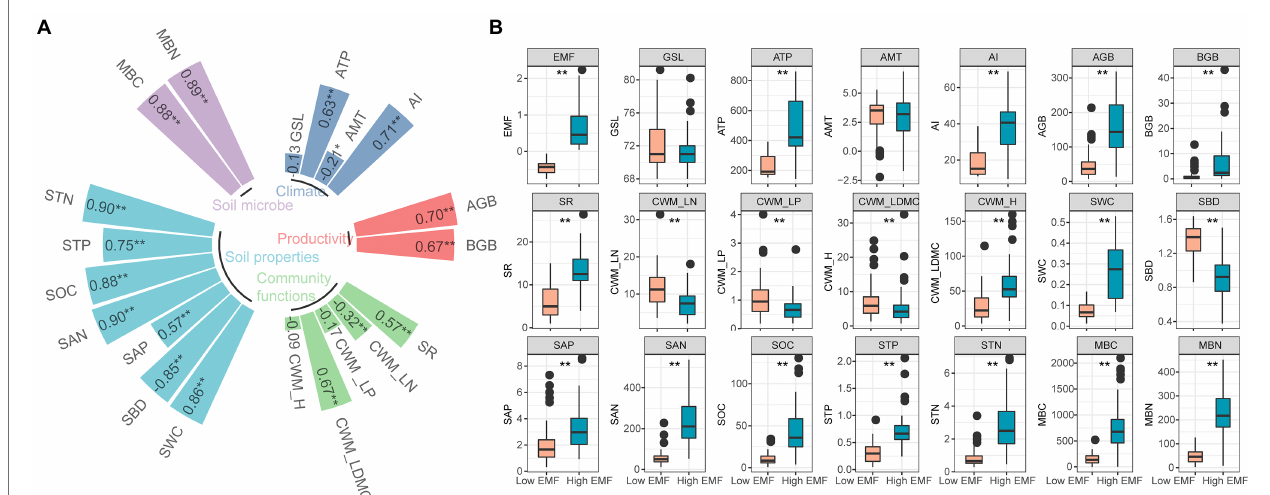
FIGURE 2 | Characteristics of ecosystem multifunctionality and environmental factors. (A) Relationship among ecosystem multifunctionality and climate, productivity, community functions, soil properties, soil microbial factors, and the value in the square represents the value of the correlation coefficient between each factor with ecosystem multifunctionality. * and ** show the significant correlations at 0.05 and 0.01 levels. (B) Difference of low and high ecosystem multifunctionality combined with environmental factors. Statistical significance between low and high ecosystem multifunctionality conditions was assessed by one-way ANOVA analysis. ** p < 0.01. EMF, ecosystem multifunctionality; GSL, start of growing season to the peak of growing season; ATP, annual total precipitation (mm); AMT, annual mean temperature ( ° C); AI, aridity index; AGB, aboveground biomass (g m − 2 ); BGB, belowground biomass (g m − 2 ); SR, species richness; CWM_LN, community-weighted mean value of leaf nitrogen; CWM_LP, community-weighted mean value of leaf phosphorus; CWM_LDMC, community-weighted mean value of leaf dry matter content; CWM_H, community-weighted mean value of plant height; SWC, soil water content (%); SBD, soil bulk density (g cm − 3 ); SAP, soil available phosphorus content (mg kg − 1 ); SAN, soil available nitrogen content (mg kg − 1 ); SOC, soil organic carbon content (g kg − 1 ); STP, soil total phosphorus content (%); MBC, microbial biomass carbon content (mg kg − 1 ); MBN, microbial biomass nitrogen content (mg kg − 1